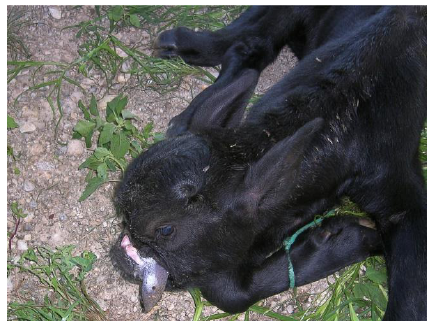
Figure 2. A newborn MIRB calf having underdeveloped incisive, maxillary, and nasal bones with a consequent tongue prolapse and lower jaw deformities. a consequent tongue prolapse and lower jaw